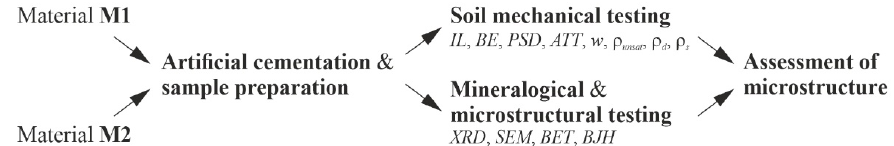
Figure 4. Summary of individual work steps for laboratory testing (flowchart).